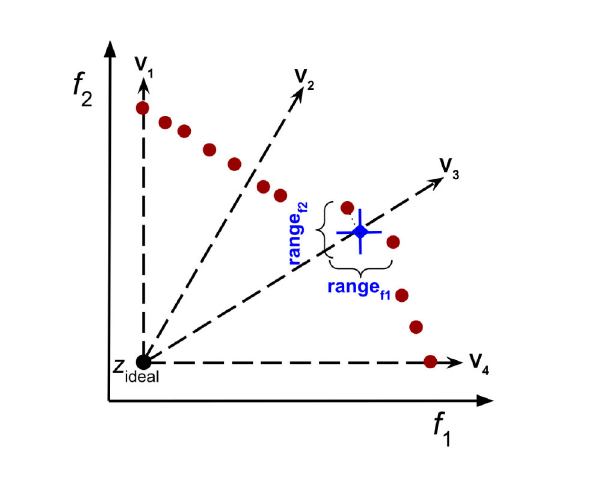
Fig. 5 Specifying desirable objective function ranges as preference information in ADM-II